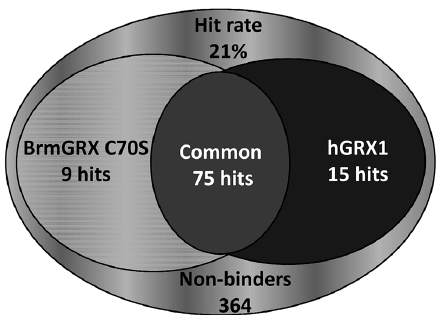
Figure 2. Venn diagram showing STD results. Fragments that interact with one GRX are selective binders. Fragments that bind to both are common binders. Non-binders are fragments that do not interact with either protein.